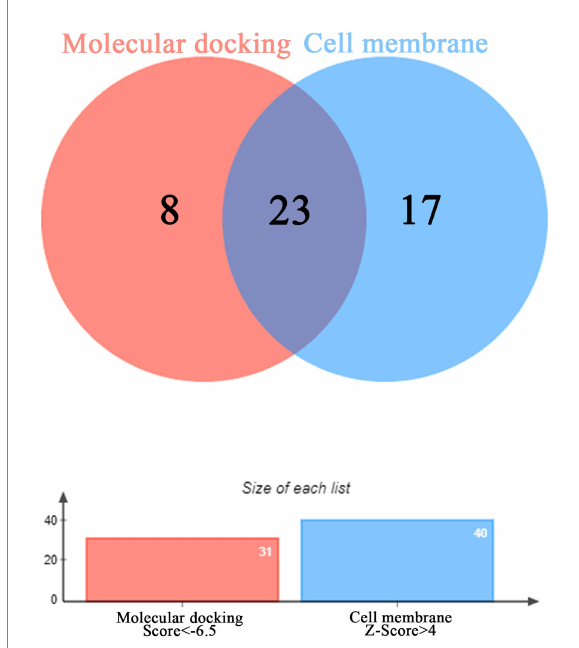
FIGURE 3 The Venny diagram of intersection targets. The intersection of protein targets highly expressed in cell membranes and protein targets tightly bound to the small molecule